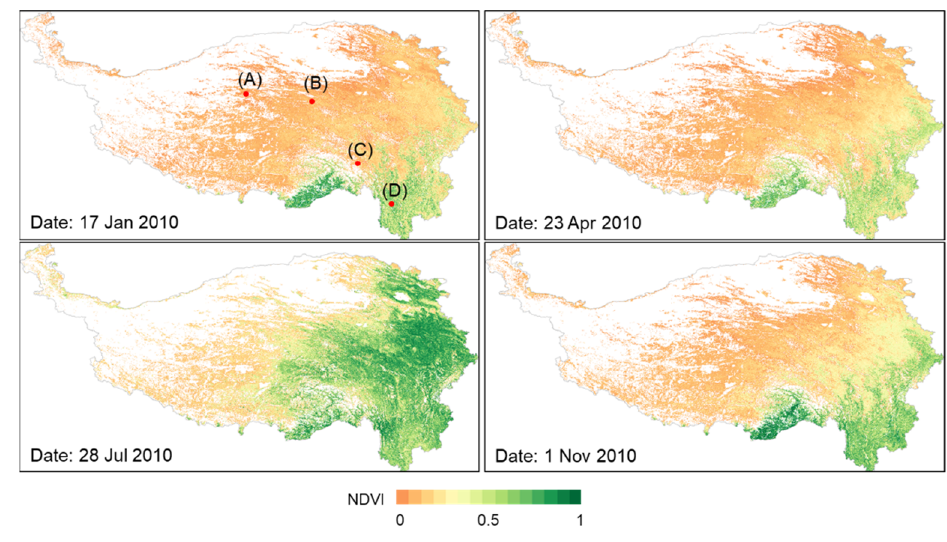
Figure 3. The spatial distribution of the reconstructed Landsat NDVI data in the year 2010 on four dates in different seasons. In the first panel, the NDVI time-series data of the four points A–D are shown in Figure 4.